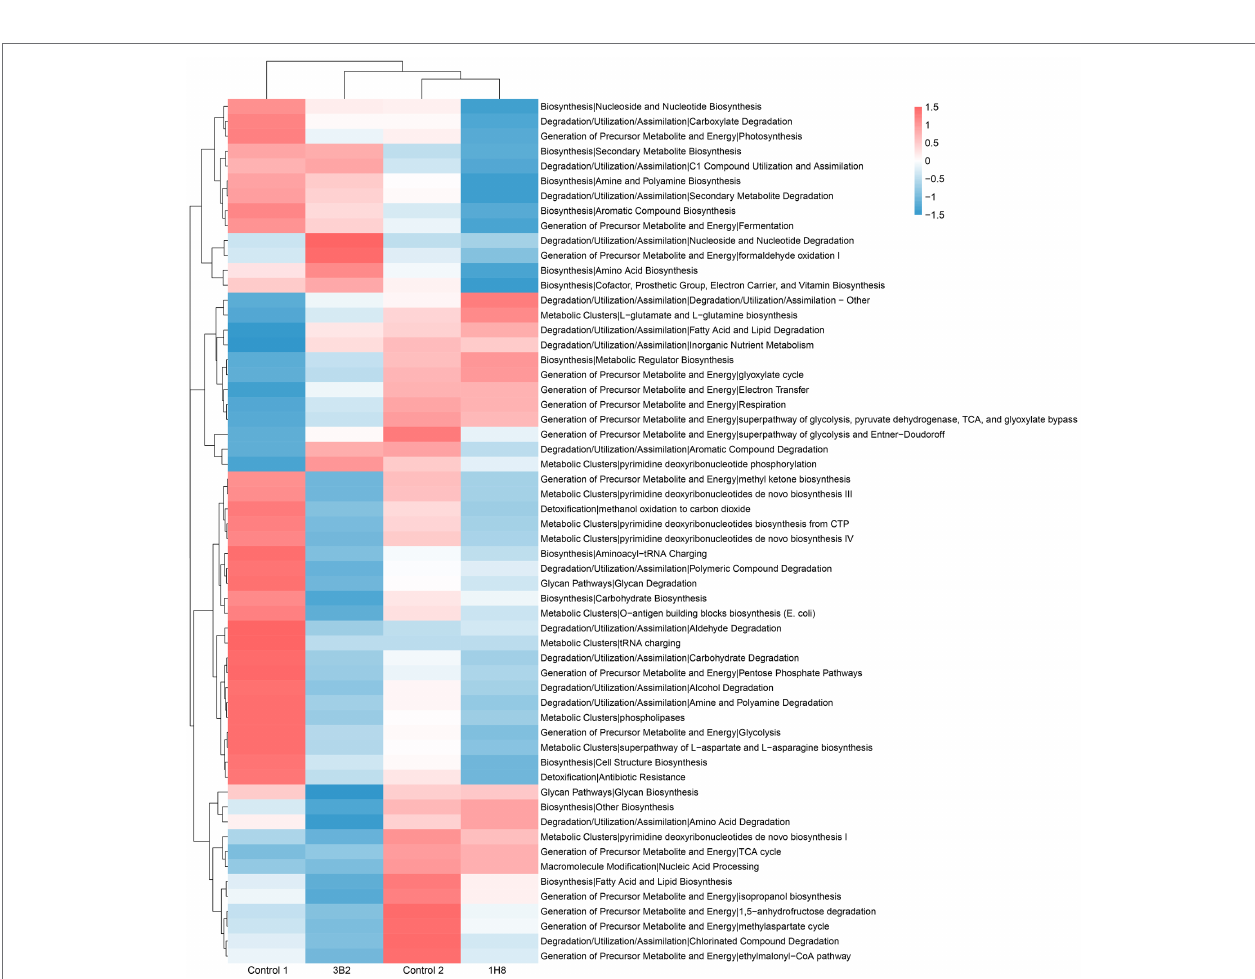
FIGURE 3 | Evolutionary branch map of the bacteria with significantly different in cigar tobacco leaves with different treatments.